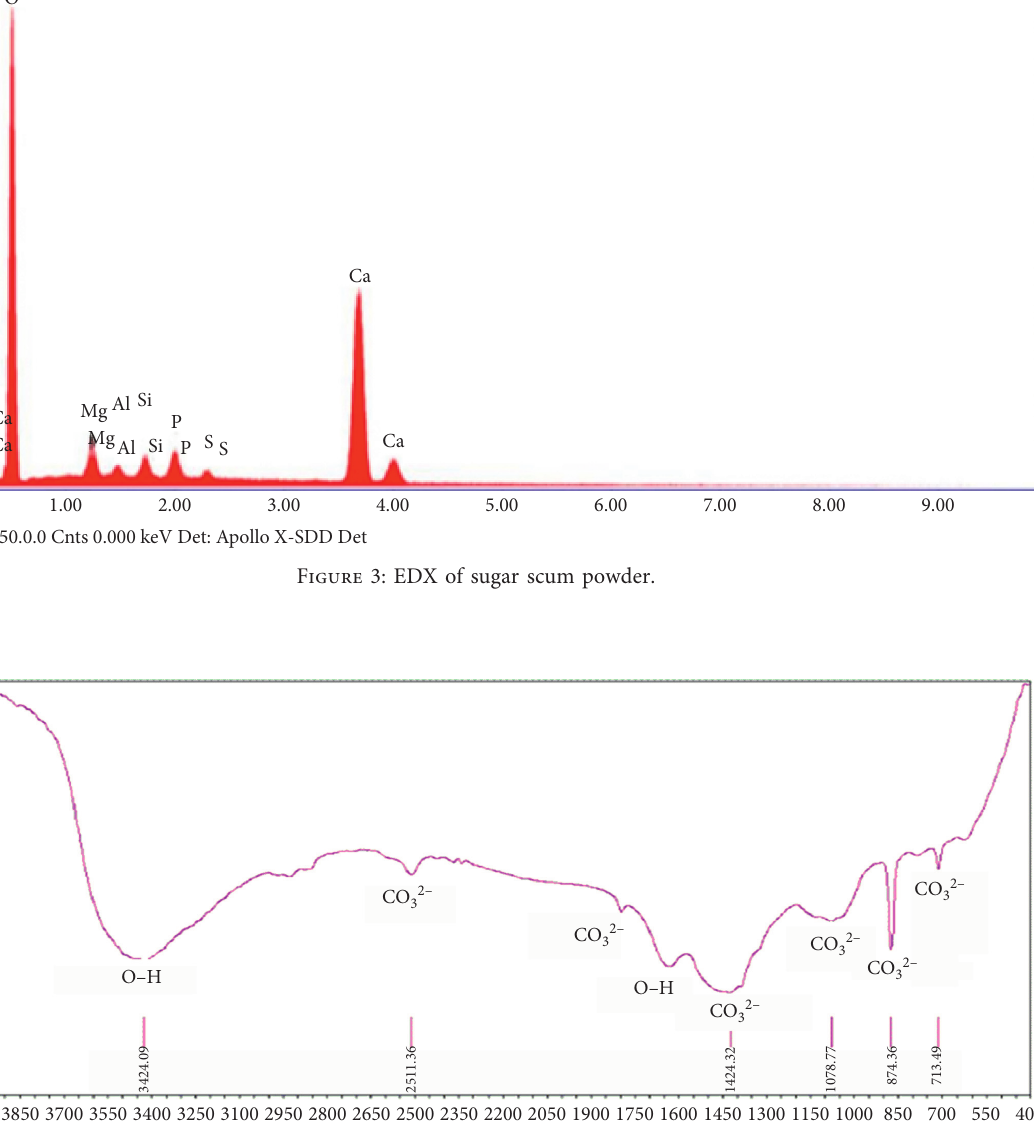
Figure 4: FTIR spectra of sugar scum powder.